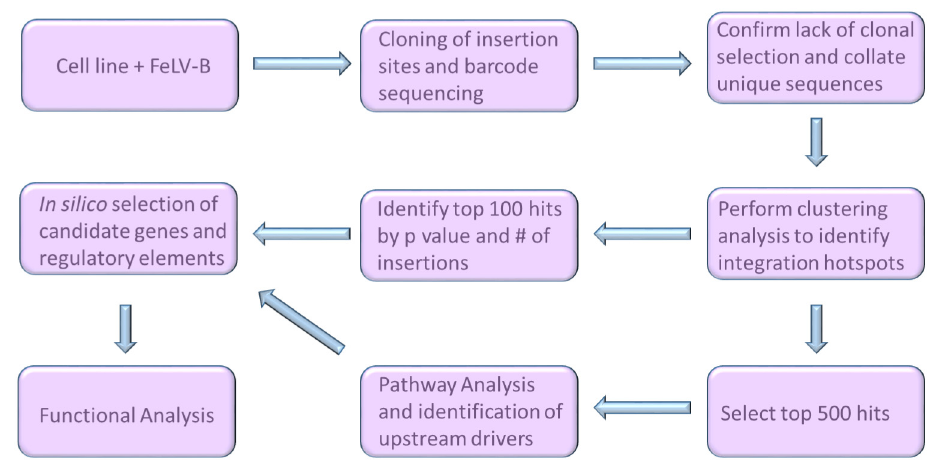
Fig 8. Overview of GRIP. Flow chart showing the experimental workflow, from infecting cells through deep sequencing and the bioinformatics steps necessary to identify candidate genes or regulatory elements.